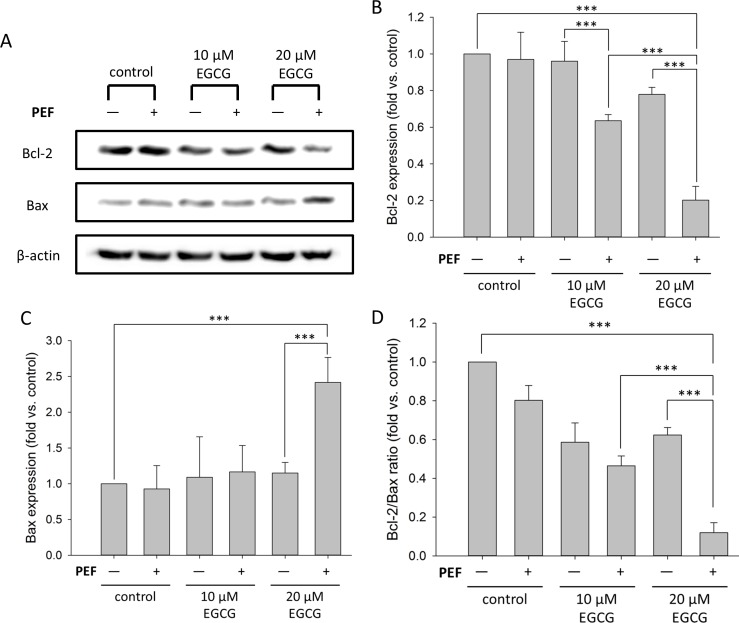
Effect of co-treatment with EGCG and PEF on the protein levels of Bcl-2 and Bax.PANC-1 cells were treated for 24 h with EGCG (10 or 20 μM) alone or combined with 60 V/cm PEF. (A) Protein expression levels of Bcl-2 and Bax were measured using Western blot analysis. Each relative expression level was normalized against β-actin and compared with control. The cells co-treated with 20 μM EGCG and 60 V/cm PEF showed significant decrease of Bcl-2 and increase of Bax. (B) Bcl-2 band intensities were quantified. When PANC-1 cells were co-treated with EGCG and PEF, Bcl-2 protein levels were significantly decreased. (C) Bax band intensities were quantified. The Bax protein level was significantly increased only when PANC-1 cells were co-treated with 20 μM EGCG and PEF. (D) The Bcl-2/Bax ratio was determined, and this result revealed that the combination treatment of low concentration EGCG and low intensity PEF promoted the down-regulation of Bcl-2/Bax ratio. The “+” means that the PEF was involved in the treatment, and the “-” means the PEF was not involved. (***, p<0.001 compared to corresponding control).